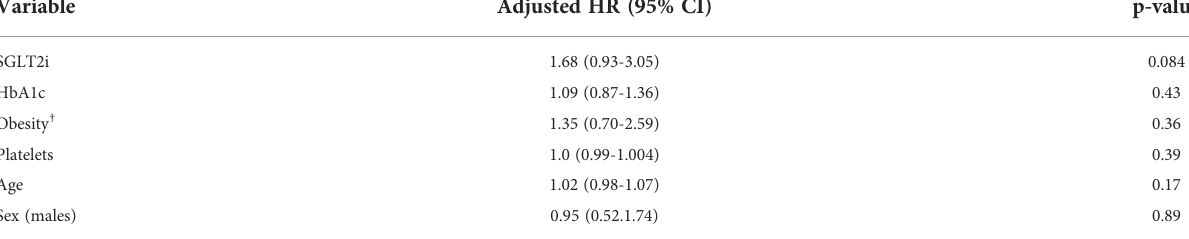
TABLE 3 Multivariate logistic regression analysis for risk of infection.